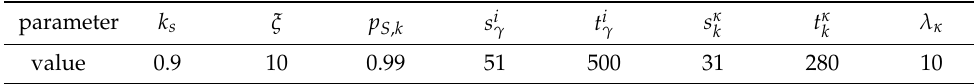
Table 1. Parameters of the fixed detection probability.